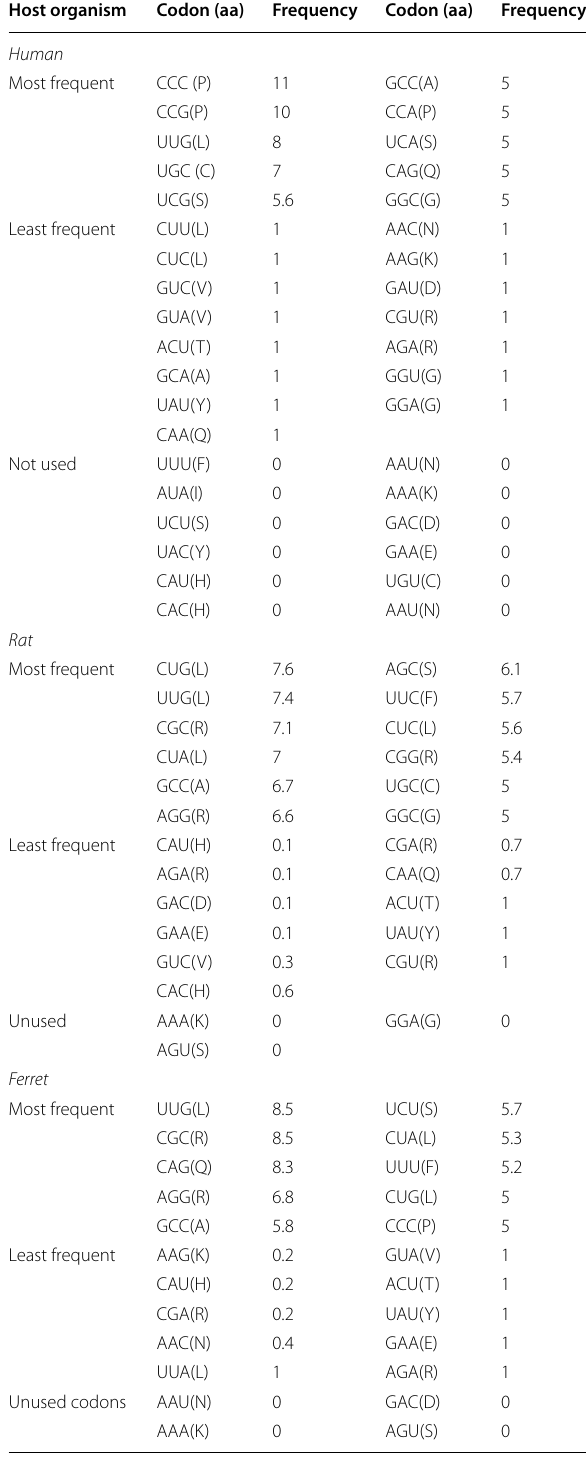
Table 4 List of used codons based on frequency in ORF4 of hepatitis E viruses The table lists codons, the amino acid (aa) encoded by the codon (in parentheses), and frequency of use (as a percentage). Codons are listed from most to least frequent. The space in the table separates the most frequently used, least frequently used and the unused codons for each